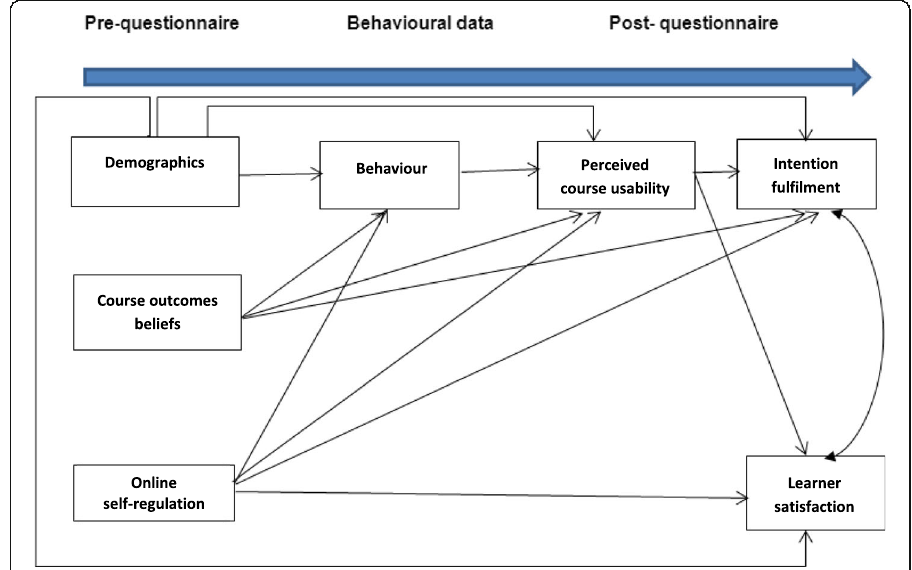
Fig. 1 A model of key factors influencing learner satisfaction and intention-fulfillment in MOOCs. The row above the model presents the timeline and the three stages of data